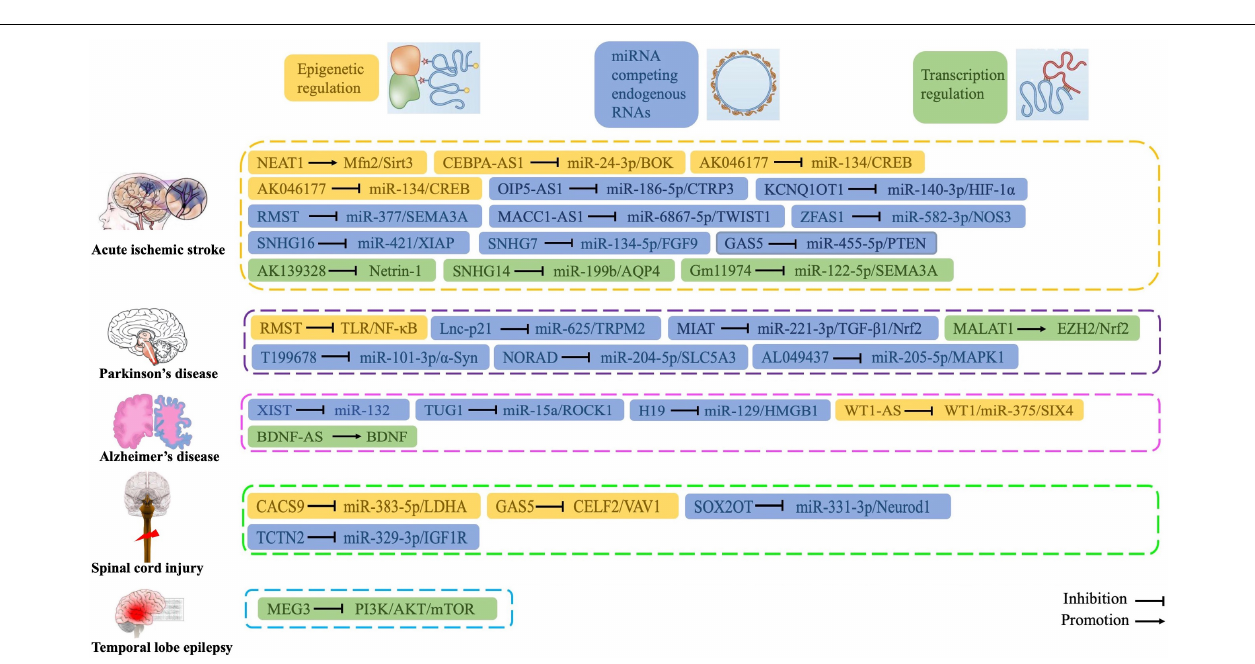
FIGURE 4 | The pathways involved in oxidative stress and in the formation of reactive oxygen species in the different pathologies of central nervous system disorders.